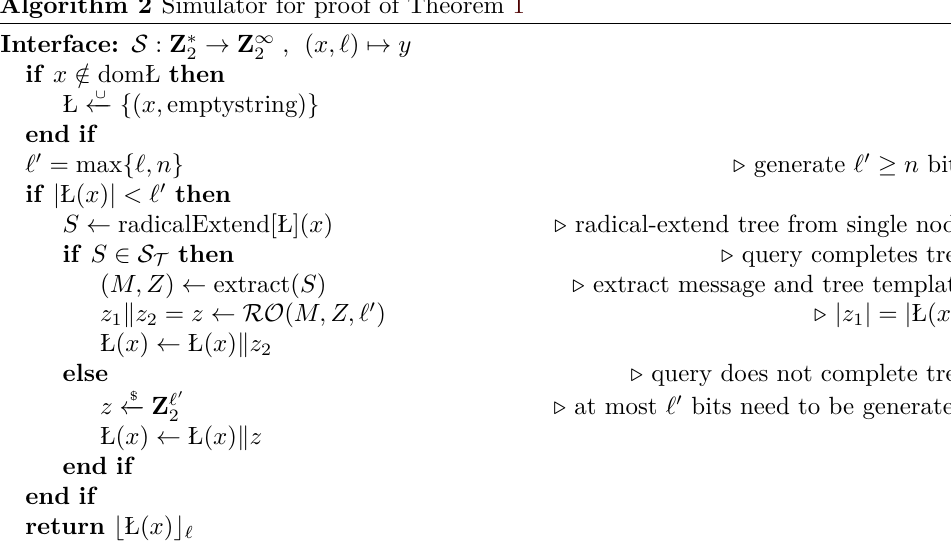
Algorithm 2 Simulator for proof of Theorem